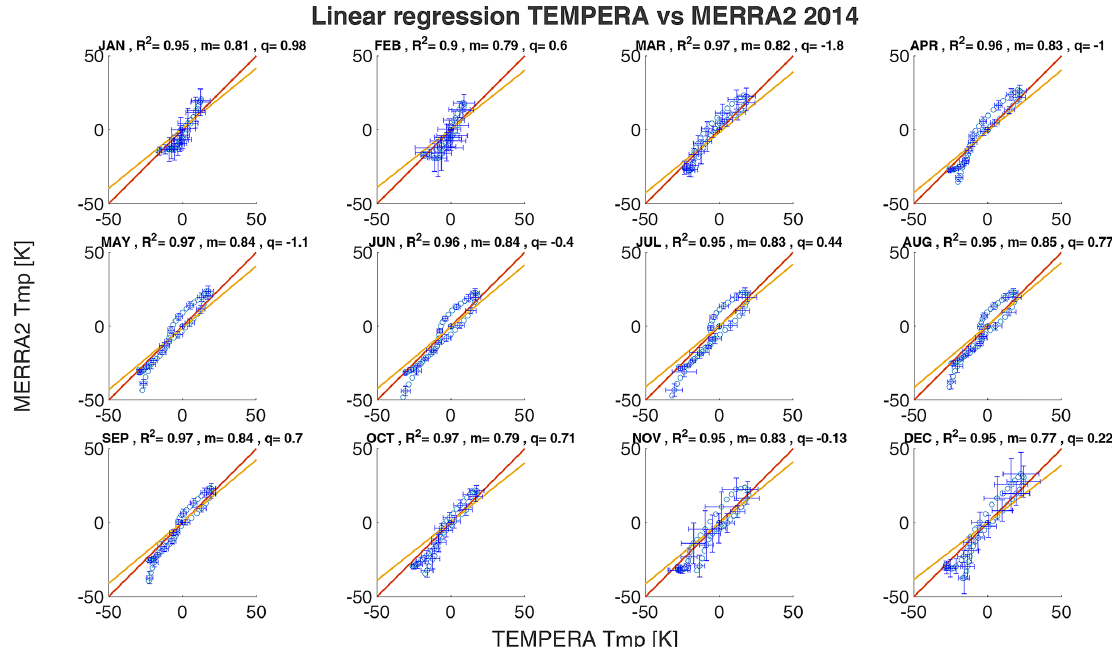
Figure A1. Linear regression of TEMPERA against MERRA2 temperatures for the year 2014.